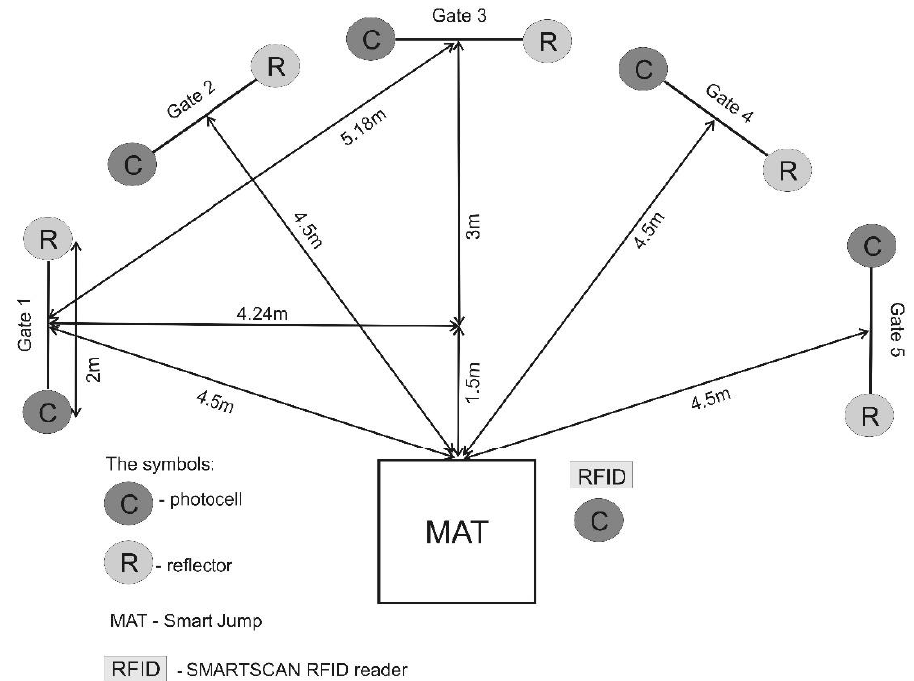
Figure 1. ‘The Five-Time Shuttle Run to Gates’ Test [4], reprinted with the author’s permission. Figure 1. ‘The Five - Time Shuttle Run to Gates’ Test [ 4] , reprinted with the author’s permission . alpha: